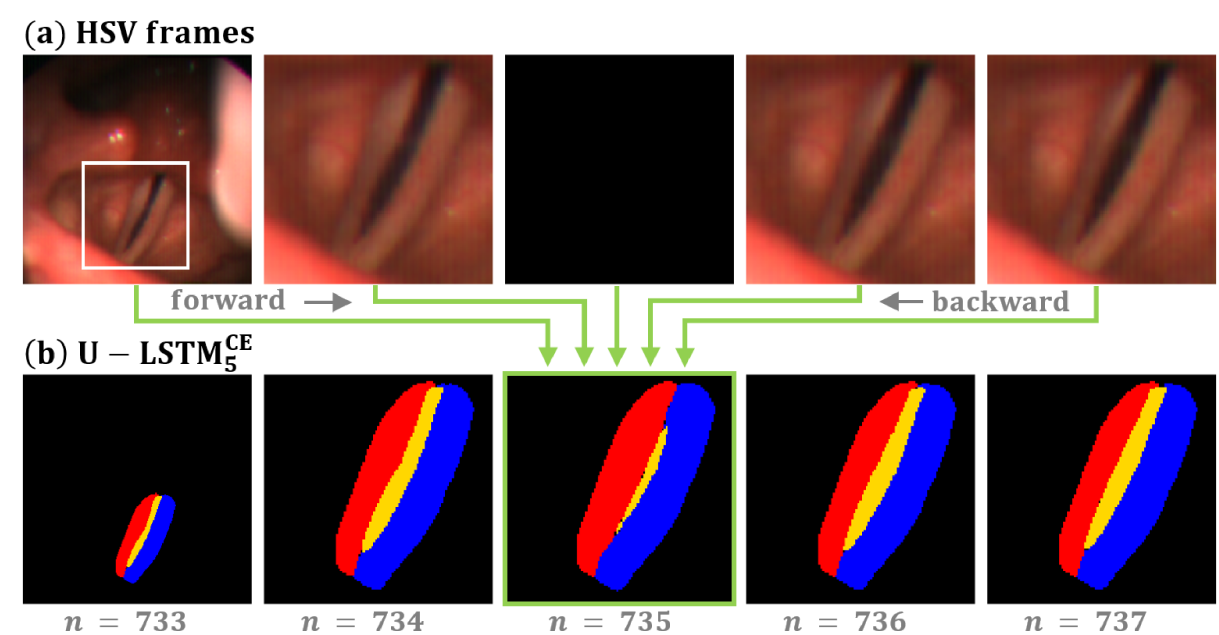
Fig 10. Exploiting temporal information by the introduced U-LSTM network to produce spatially and temporally consistent segmentation results. (a) Test dataset with an artificially included empty (black) image. (b) Segmentation result of the best performing U (cid:0) LSTM CE